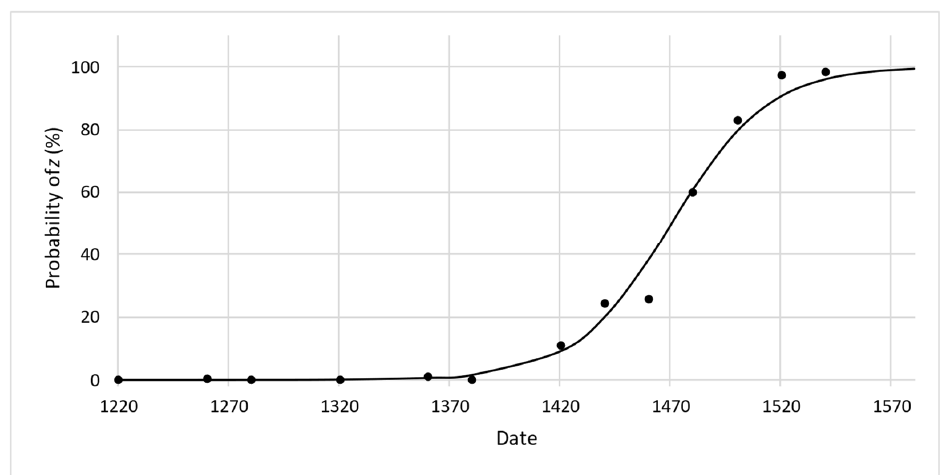
Figure 1. The replacement of preconsonantal coda d by z , together with a best-fit logistic curve. Parameters: − 11.431566 (intercept), 0.045686 (slope). p -value: <2 × 10 − 16 (i.e., almost 0).